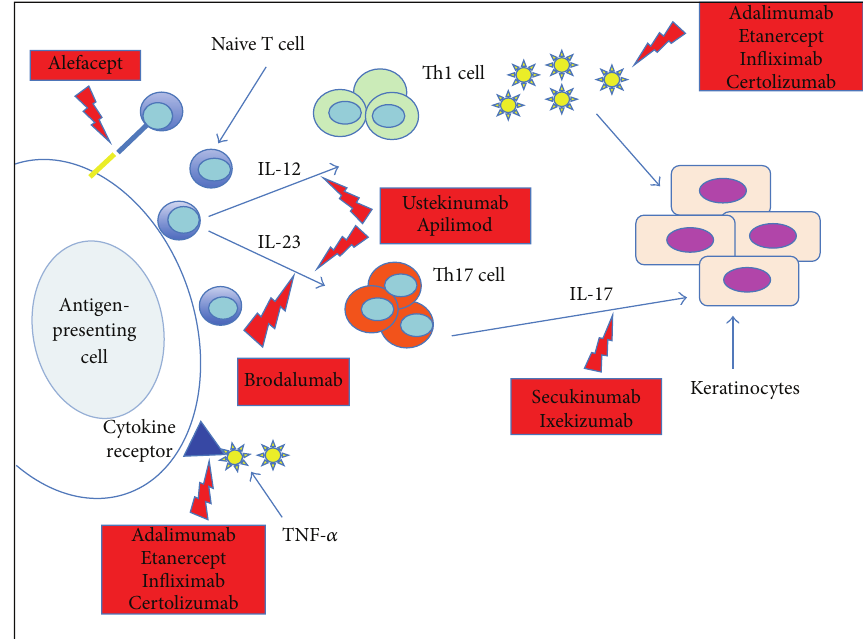
Figure 1: Schematic representation of biological therapy of